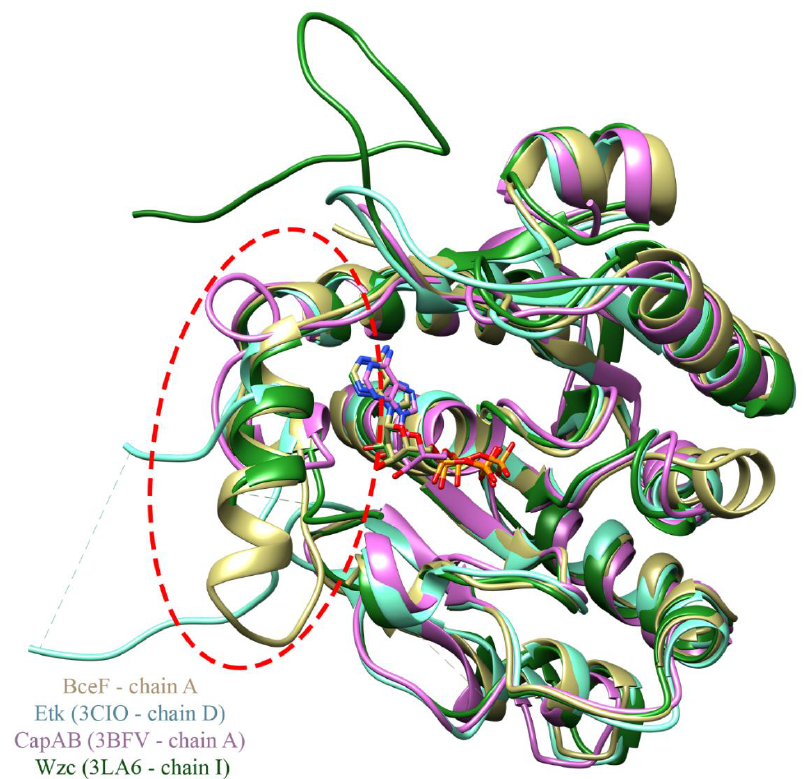
Figure 3. Structural superimposition of the BceF, Etk, CapA/B, and Wzc kinase domains. Ribbon diagrams of the structure of BceF from B. cepacia colored in beige; Etk from E. coli in cyan (PDB: 3CIO [12]); CapA/B from S. aureus is purple (PDB: 3BFV [14]); Wzc from E. coli in dark green (PDB: 3LA6 [11]). Dashed lines represent regions that could not be resolved in the respective crystal structures. ADP, present in the crystal structure of BceF, CapA/B, and Wzc, is shown in balls and sticks and is colored by atom-type (beige, purple, and dark green carbons for the ADP from BceF, CapA/B, and Wzc, respectively). An evolutionary variable region (Figure 1) that is also structurally different between the kinases is evident on the utmost left side of the structures in this view, marked by a dashed red circle. The RMSD between BceF and Etk is 0.881 Å for 196 successfully aligned atom pairs, or “pruned” by the default criteria in Chimera [20], and 3.305 Å for all 238 pairs. The RMSD between BceF and CapA/B is 1.100 Å for 186 pruned atom pairs and 3.867 Å for all 232 pairs, and between BceF and Wzc is 0.885 Å for 208 pruned atom pairs and 1.930 Å for all 235 pairs.